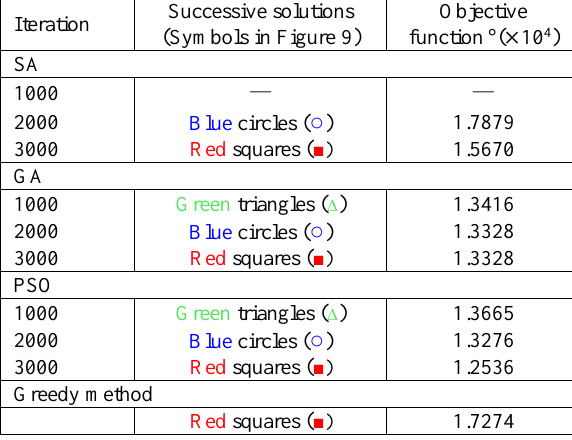
Table 5. Successive solutions and objective